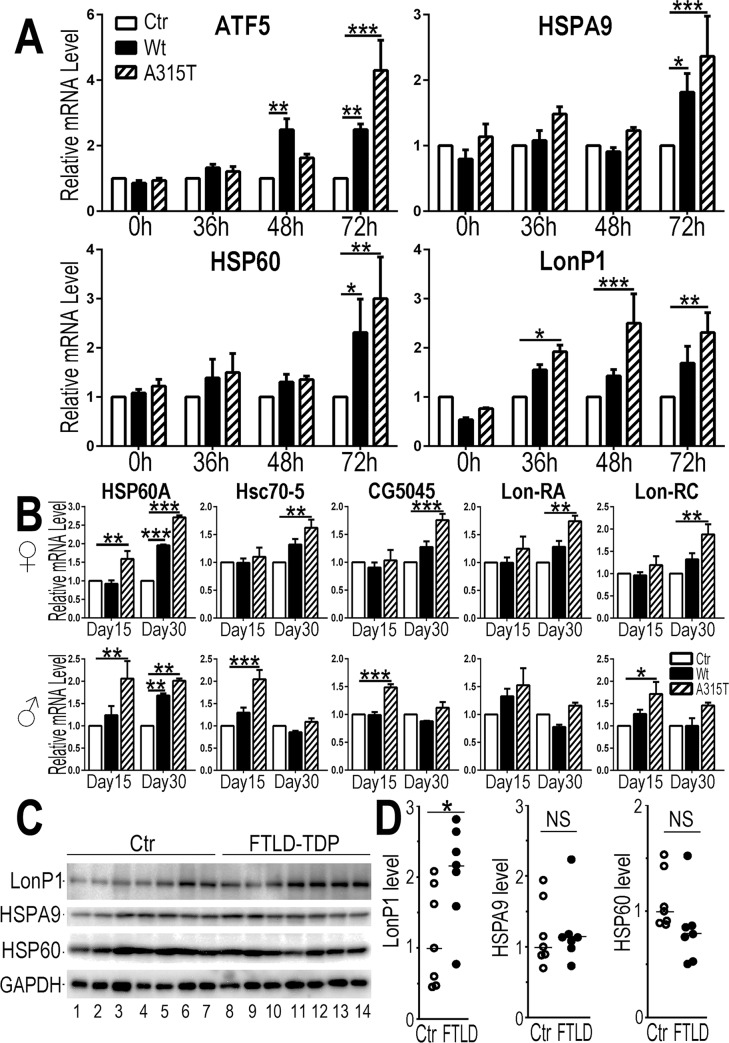
Increased expression of UPRmt genes in HEK293 cells and flies expressing TDP-43, and elevated LonP1 protein in FTLD-TDP brains.(A) Expression levels of UPRmt related genes, including ATF5, HSPA9 (mtHSP70), HSP60 and LonP1, as detected by qPCR in TDP-43 inducible stable cells at different time points following induction of TDP-43 expression: 0, 36, 48 and 72-hr time points. HPRT1 was used as an internal control. (B) Expression levels of UPRmt related Drosophila genes in female and male flies, including HSP60, Hsc70-5 (mtHSP70), CG5045 (ClpP homolog) and Lon (Lon-RA and Lon-RC isoforms), as detected by qPCR in Elav-Gal4/Tub-Gal80ts driven TDP-43 transgenic flies at day 15 and day 30 post-induction of TDP-43 expression. Actin 5C was used as an internal control. Fly genotypes: Ctr: Elav-Gal4/Tub-Gal80ts /UAS-RFP; Wt: Elav-Gal4/Tub-Gal80ts/UAS-Wt-TDP-43-RFP; A315T: Elav-Gal4/Tub-Gal80ts /UAS-A315T-TDP-43-RFP. Data from 3 independent experiments (panels A and B) were analyzed using a two-way ANOVA with Bonferroni post hoc test (*:P<0.05; **:P<0.01; ***: P<0.001). (C-D) Western blotting analyses using brains from control or FTLD-TDP patients show that LonP1 protein levels were higher in brain samples from patients affected by FTLD-TDP as compared with the control subjects. The levels of HSPA9 and HSP60 proteins were not changed in the patient brains. These brain samples have been reported previously [40]. Data were analyzed using StatPlus with a Student’s t-test (*:P<0.05; NS: not significant).